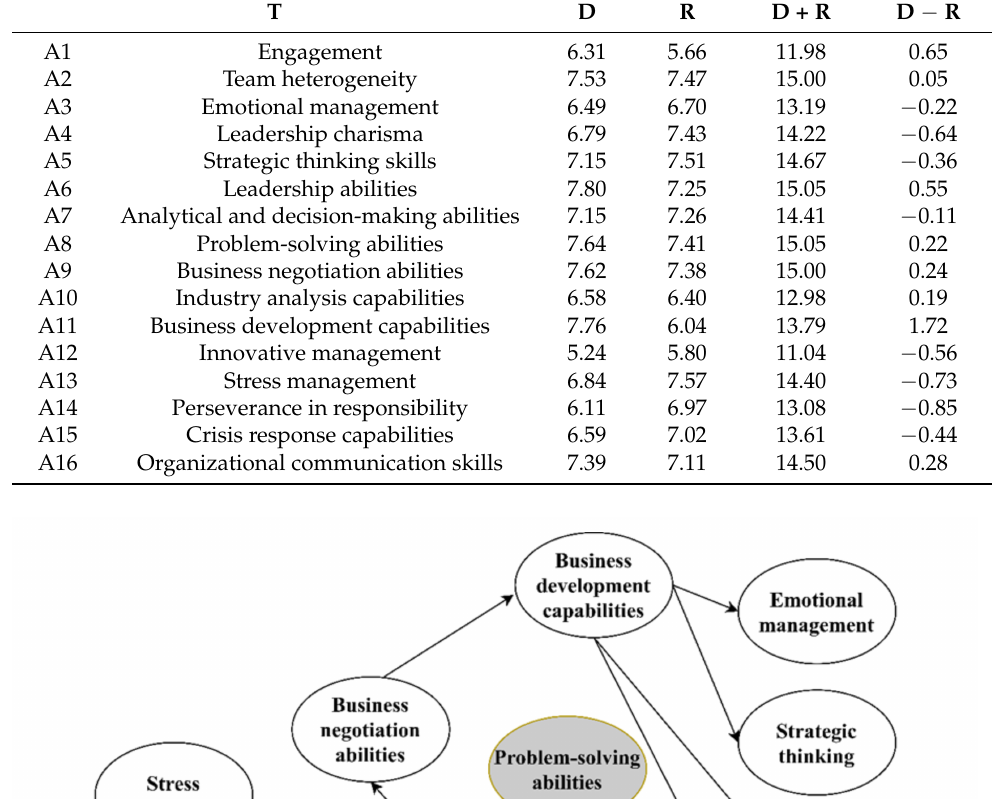
Table 9. Importance and causality of each criterion.